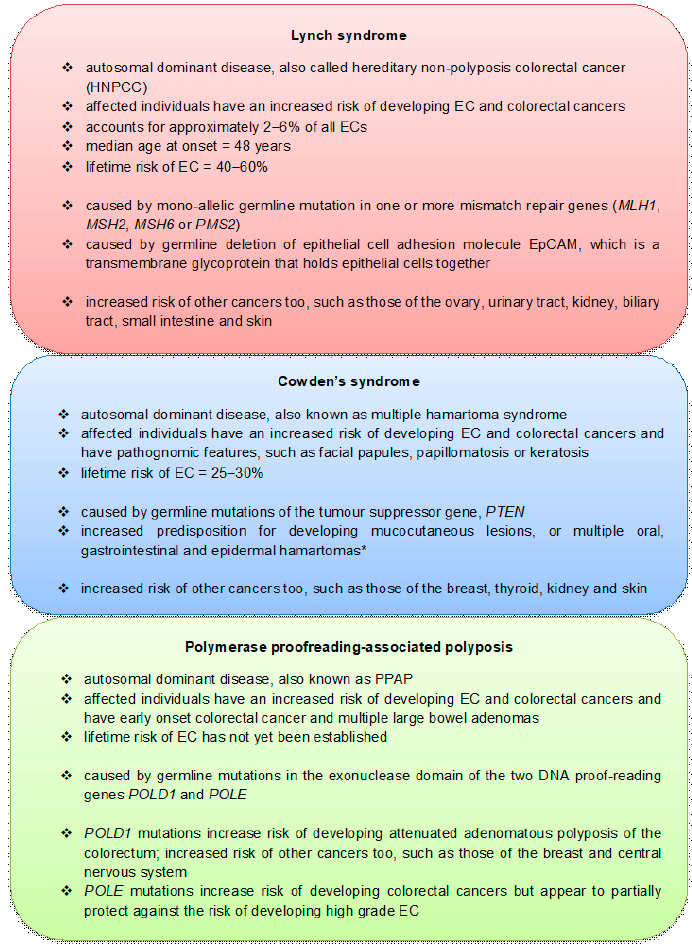
Figure 5. Hereditary syndromes manifesting as increased risk of developing EC. Each of these diseases is inherited in an autosomal dominant manner and each is a non-modifiable risk factor for the development of EC. The mismatch genes, MutL Homolog 1 ( MLH1 ), MutS Homolog 2 ( MSH2 ), MutS Homolog 6 ( MSH6 ) and PMS1 Homolog 2, Mismatch Repair System Component ( PMS2 ) are all component parts of the post-replicative DNA mismatch repair system (MMR) that coordinately repairs double stranded DNA errors. Mutations of these genes prevents DNA repair. * A hamartoma is a tumour-like, non-neoplastic disordered proliferation of mature tissue.